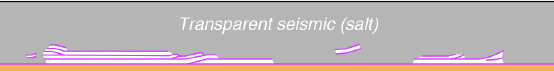
Figure 15. Simplified sketch based on observations of 3-D seis- mic data in the northern Red Sea. The bright package (in purple) locally at the base of the Mansiyah salt (in grey) is the Kial Forma- tion, which includes significant proportions of anhydrite (Hughes and Johnson, 2005). The Kial has variable expression: as coherent bedding, as slightly disrupted bedding (due to thrusting), as isolated stringers near the base of salt, or absent. Thus, the base of the mo- bile, transparent salt (grey) cuts up and down